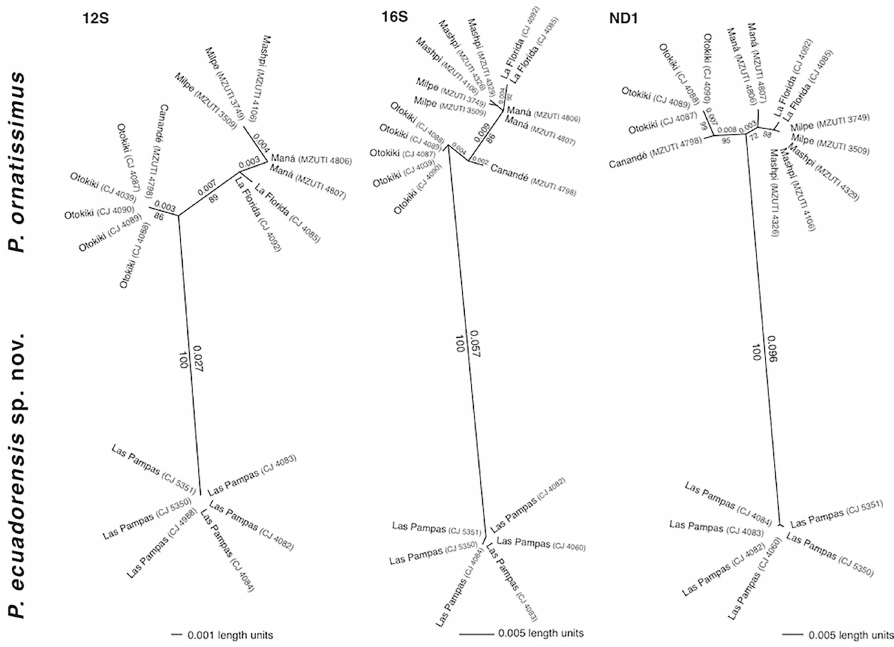
Fig 4. Mitochondrial genetic structure among populations of Pristimantis ornatissimus and P . ecuadorensis sp. nov. as inferred from maximum likelihood analyses. Branch lengthsand significant bootstrapvalues are presentedfor each tree. Note reciprocal monophylyand geneticdistances between P . ornatissimus sensu stricto and P . ecuadorensis sp. nov.